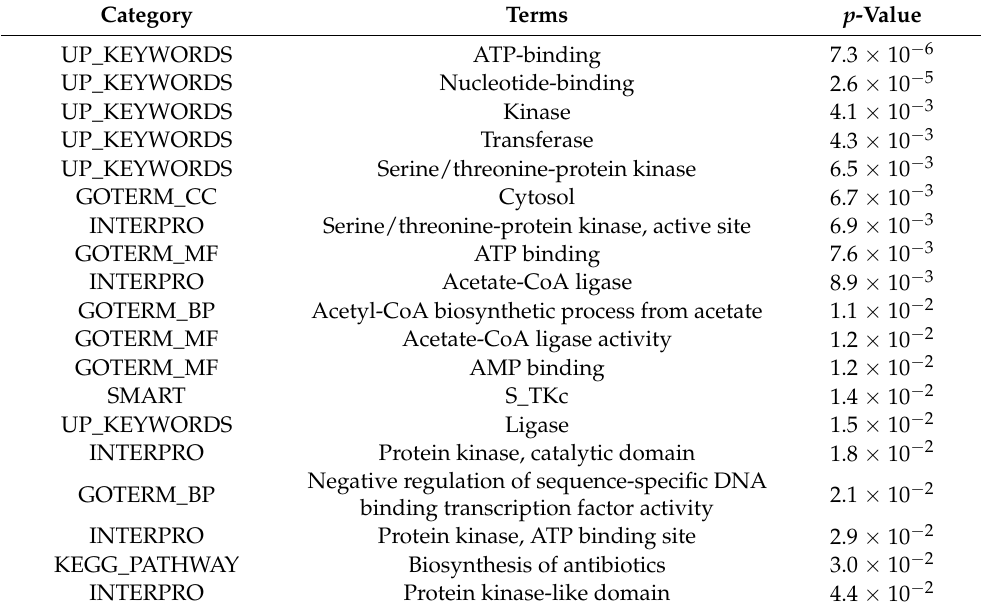
Table 3. GO enrichment analysis of 61 fungal proteins, including 6 proteins specifically identified at 24 hpi and 55 proteins commonly identified at 4 and 24 hpi. UP: UniProt, BP: biological process, CC: cellular component, MF: molecular function, KEGG: Kyoto Encyclopedia of Genes and Genomes. Cutoff p -value <